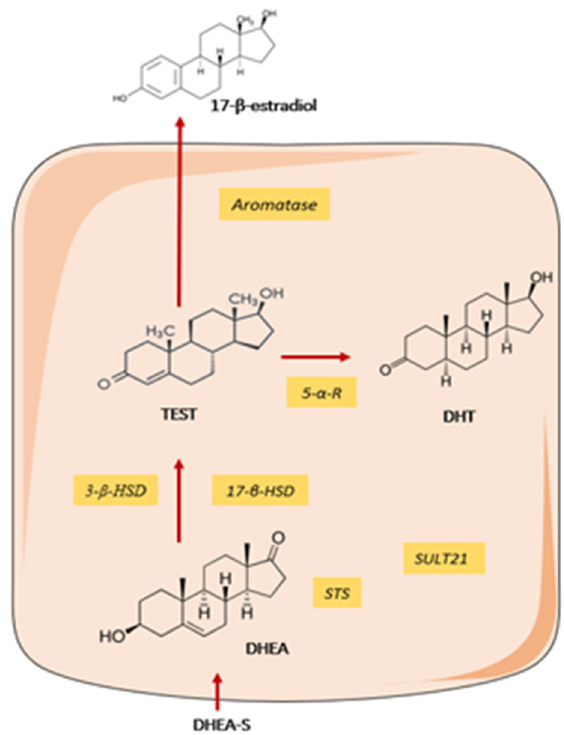
Figure 3. Intracrine steroidogenic machinery in healthy acinar cells. The figure shows the conversion of dehydroepiandrosterone (DHEA) to active sex steroids. STS: steroid sulphatase, SULT2B1: sulfotransferase 2B1, HSD: hydroxy steroid dehydrogenase, 5- α -R: 5 α -reductase, TEST: testosterone, DHT: dihydrotestosterone. DHEA-S: DHEA-sulphate.